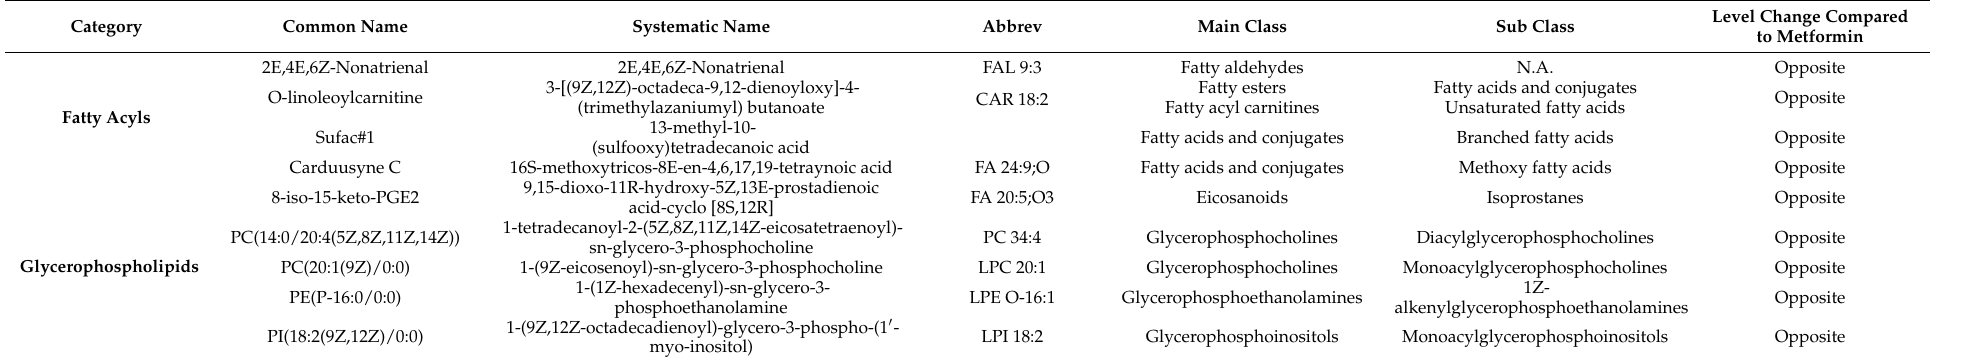
Table 2. Metformin-dependent lipids and their